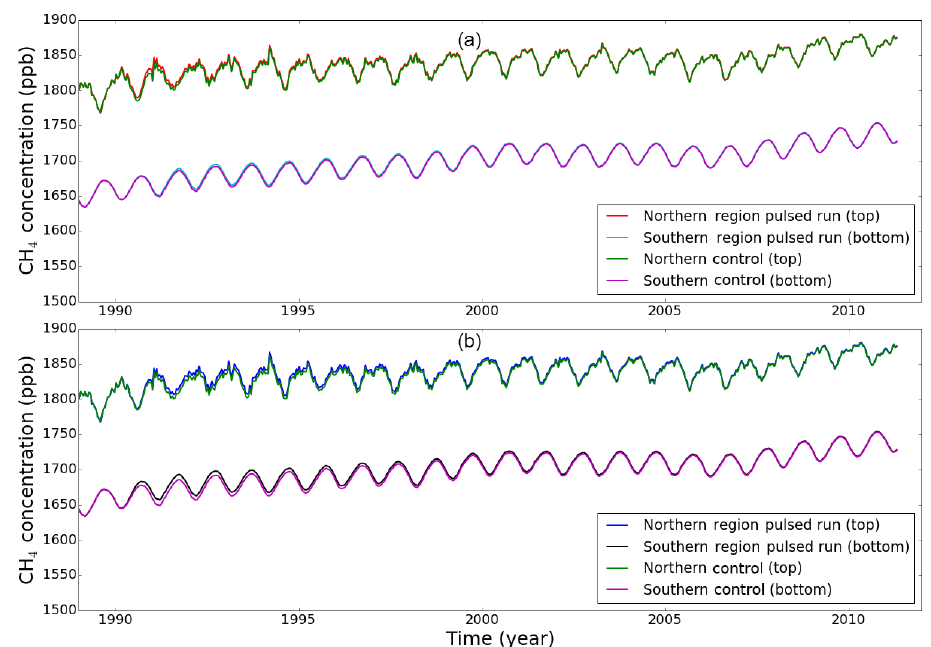
Figure B1. TM5 model CH 4 mole fractions (ppb) sampled at polar regions (Table 1) and weighted inversely by station latitude and standard deviation of the data at that site (see main text). (a) shows the response of a 10Tg pulse over mid-latitude USA in 1990 over the northern and southern pole. (b) shows the response of a 20Tg pulse over the tropics during